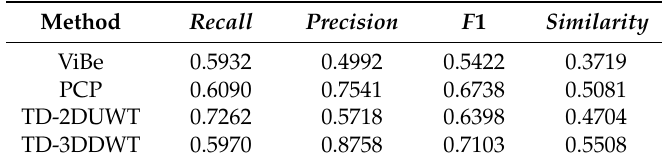
Table 1. Comparison of metrics for the eighth frame of SC96 (Frame 1827).